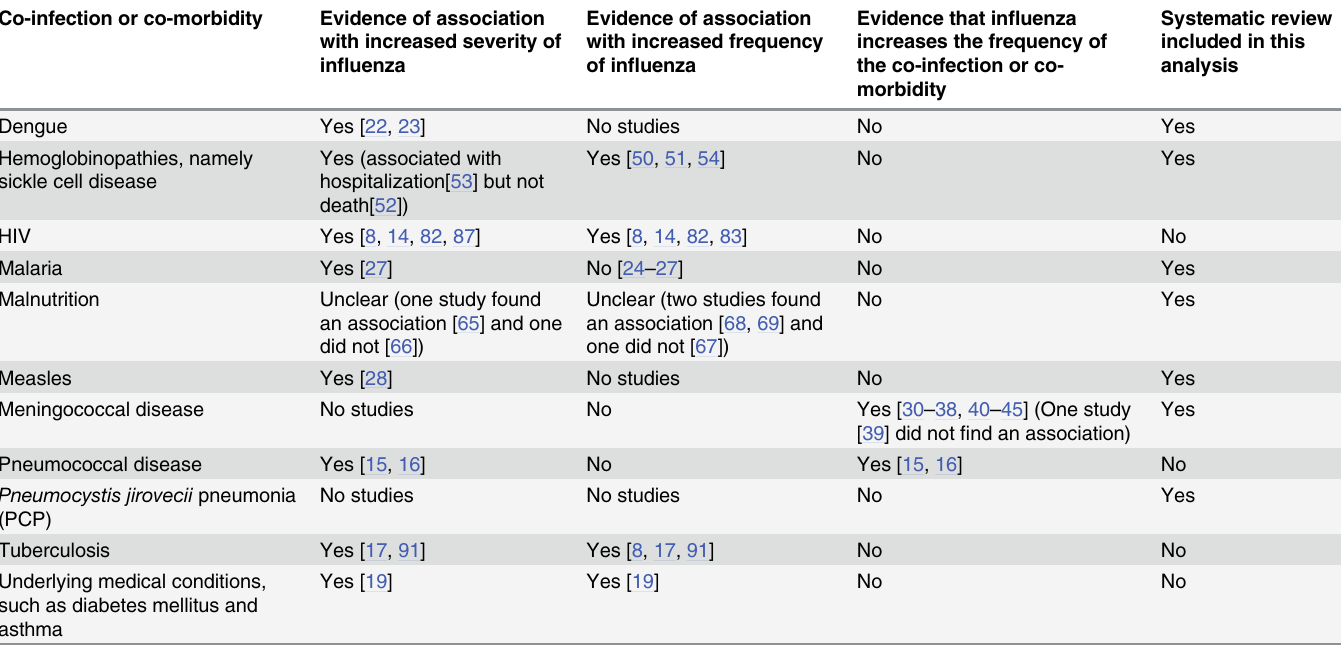
Table 3. Associations of co-infections and co-morbidities prevalent in Africa with increased severity or incidence of